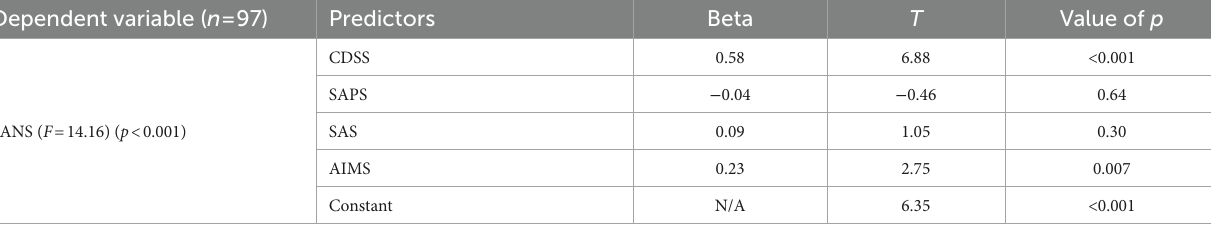
CDSS, Clinical Decision Support Systems; SAPS, Scale for the Assessment of Positive Symptoms; SAS, Self-Rating Anxiety Scale; AIMS, Abnormal Involuntary Movement Scale; SANS, Scale for the Assessment of Negative